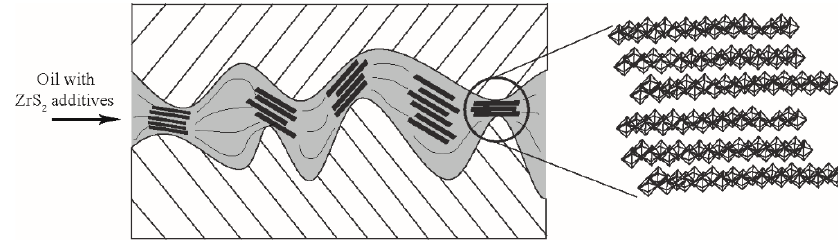
Figure 10. Schematic diagram of friction ‐ reducing of lamellar ZrS 2 nanobelts additive.